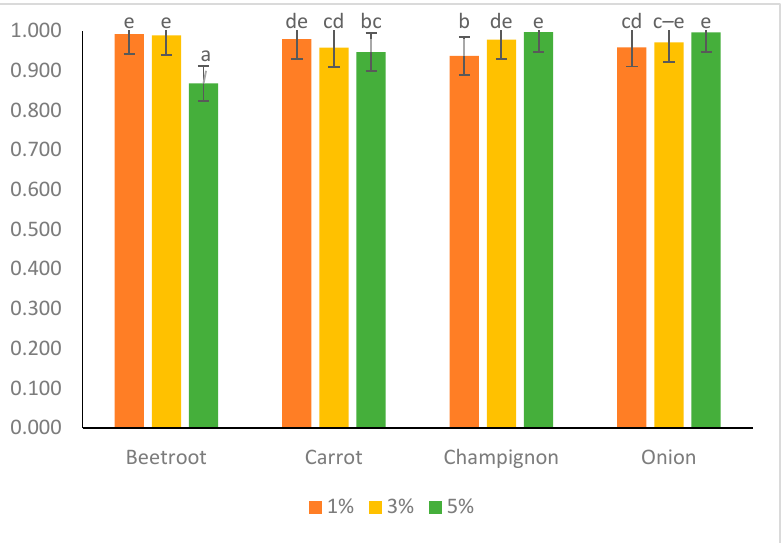
Figure 3. Effect of different amounts of dried vegetable powders on water activity of fat-free dairy desserts. Letters (a–e) indicate significant differences at p < 0.05 (Tukey’s HSD test).